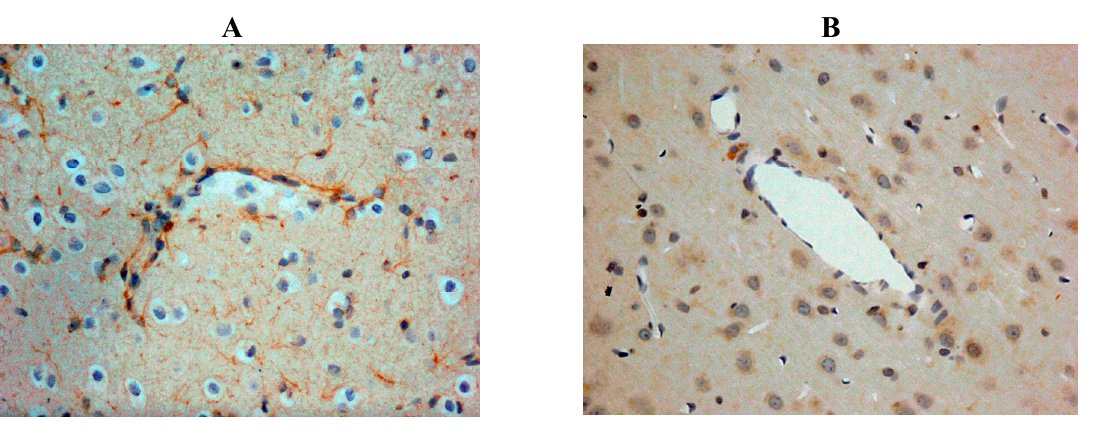
Figure 2. Increased SP immunreactivity was observed at 24 h following acute ischaemic stroke ( A ), as compared to shams ( B ). This was particularly prominent in the perivascular